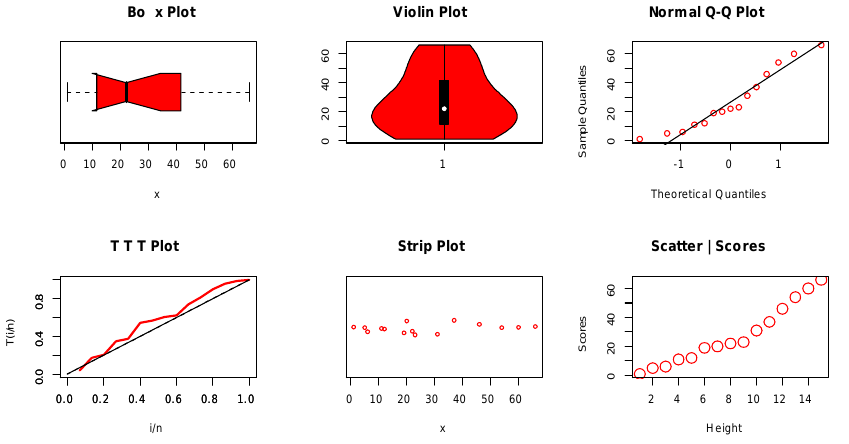
Figure 8 . Non-parametric visualization plots for EC data. Figure 8. Non-parametric visualization plots for EC